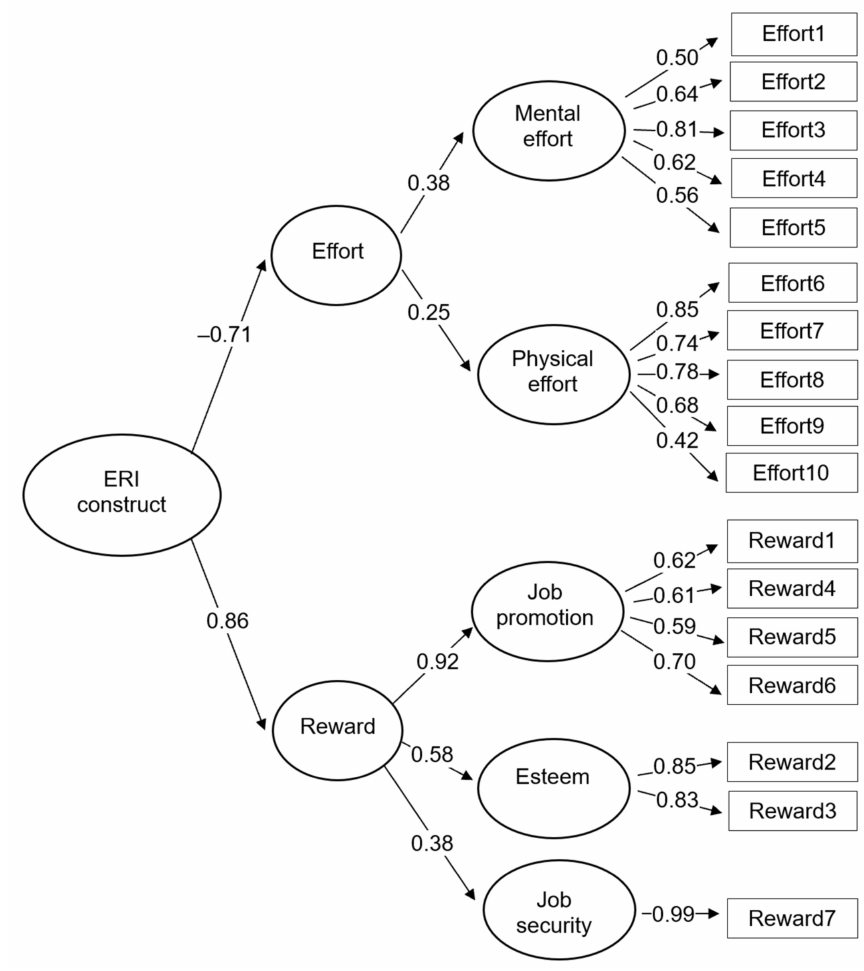
Figure 1. Confirmatory factor analysis testing the theoretical construct underlying the ERI measure. Table 2. Scores of effort–reward imbalance at work by drug misuse [means